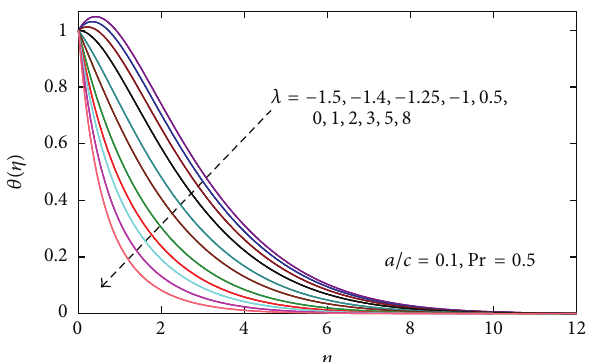
Figure 6: Temperature profiles 𝜃(𝜂) for various values of 𝜆 with 𝑎/𝑐 = 0.1 .